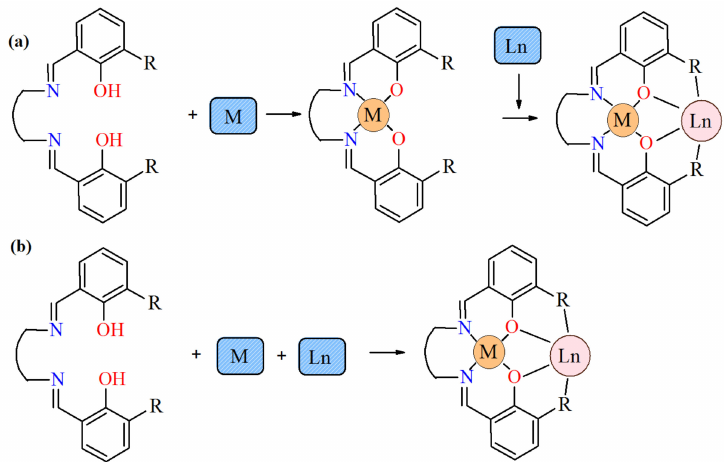
Figure 1. Methods synthesis of salen-type Schiff base heteronuclear complex: ( a ) a stepwise reaction;